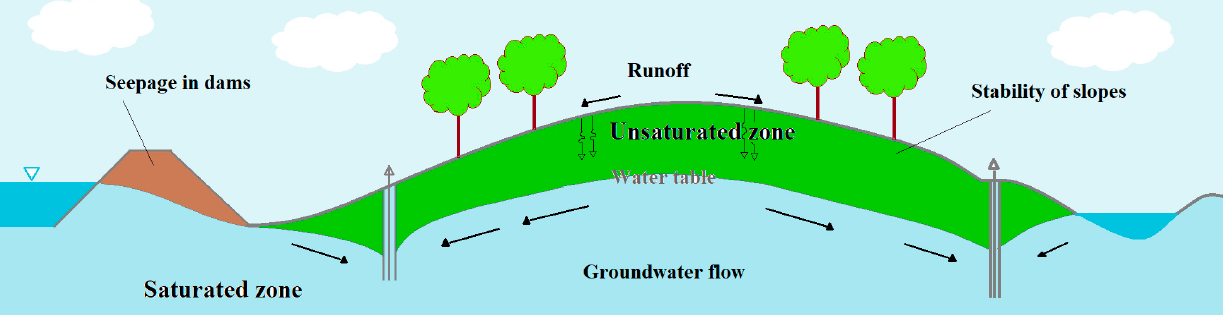
Figure 1. Schematic of seepage in soil.